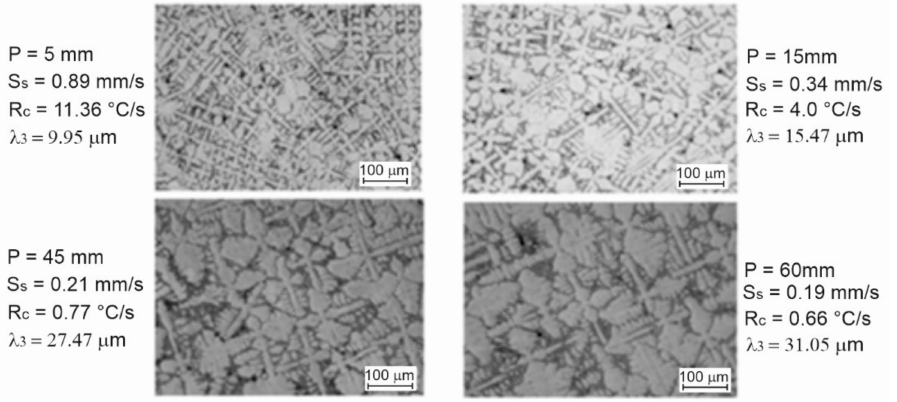
Figure 11. Morphological behaviour of Cu-Sn alloy positioned at 5, 15, 45, and 60 mm